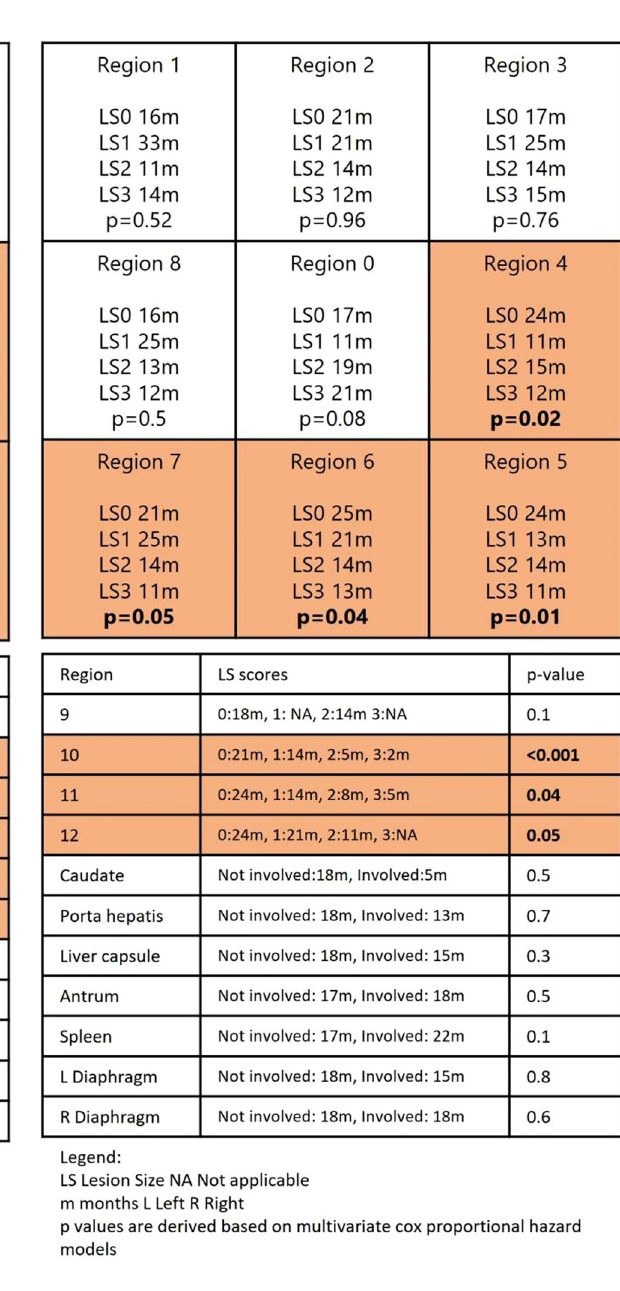
Figure 5: PCI distribution/lesion size (LS) score and progression free survival